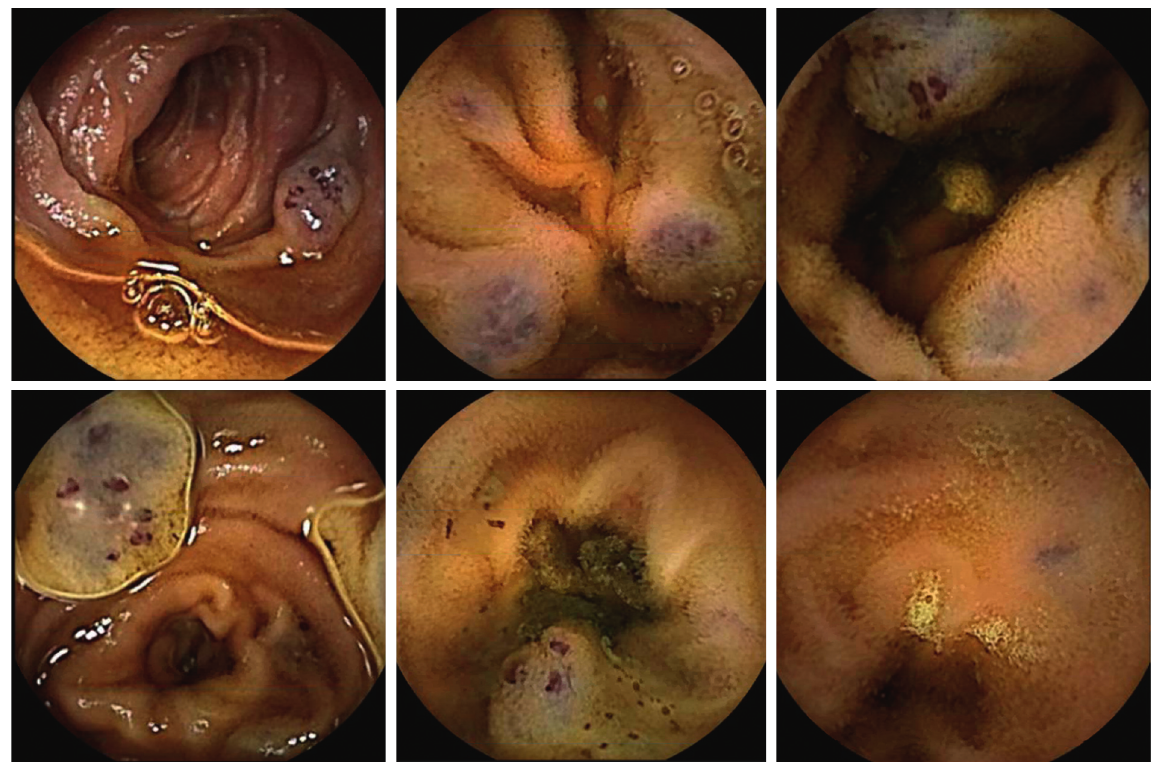
Figure 1: Images from the capsule endoscopy as it progressed through the GI tract display characteristic blue rubber blebs. These vascular ectasias are suggestive of cavernous hemangiomas and AVM. The lesions appear most frequently in the duodenum and gradually decrease in size and density in the distal small